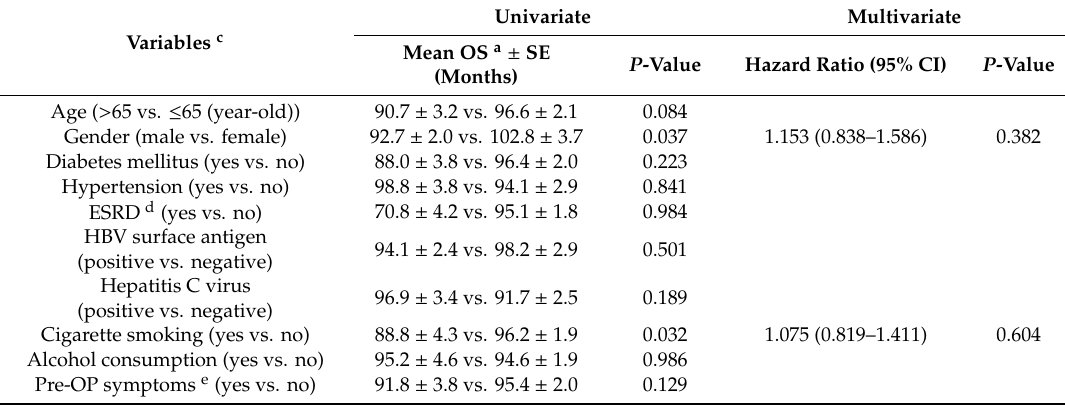
Table 4. Univariate and cox regression multivariate analyses of factors associated with OS a in N-HCC b after